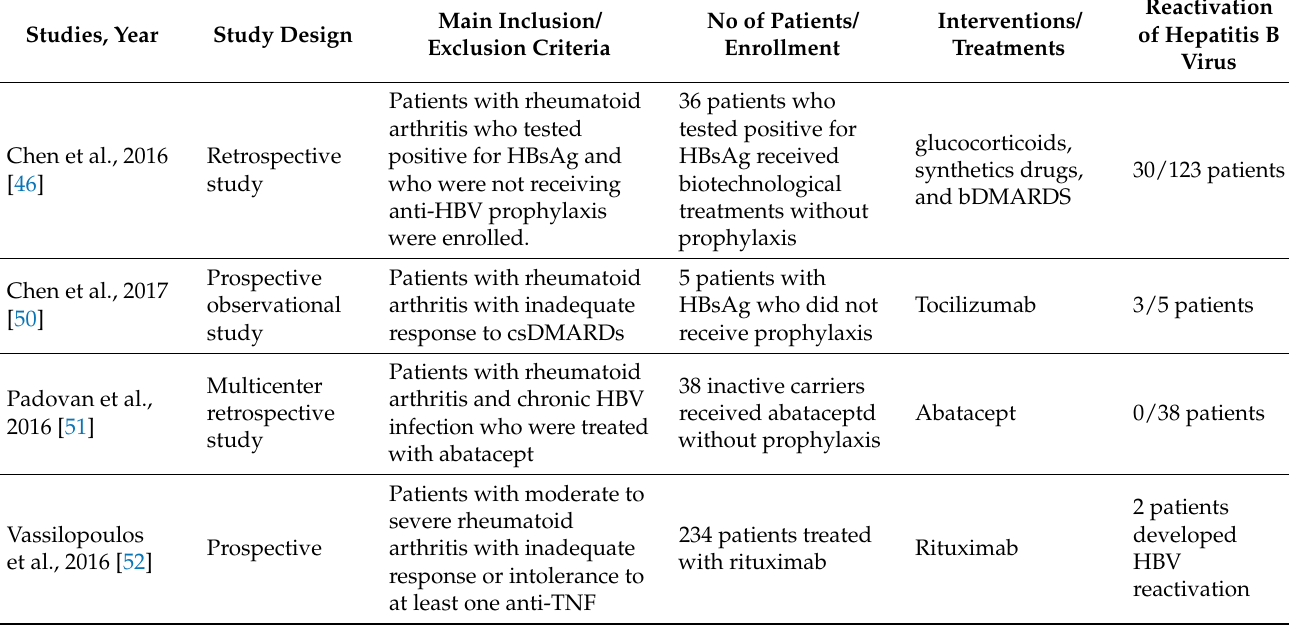
Table 2. Main studies on reactivation in chronic HBV-infected patients treated with rheumatologic drugs.